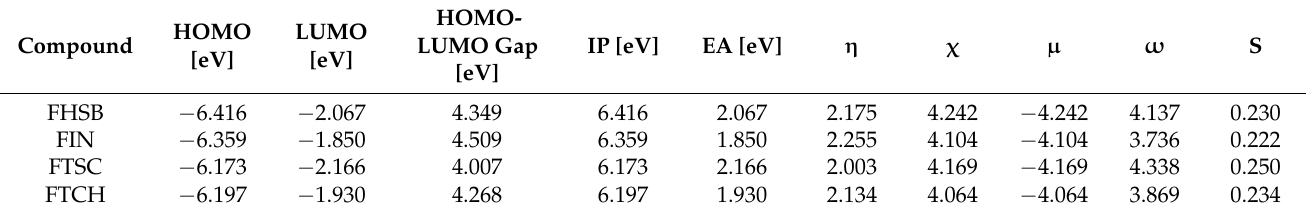
Table 2. Quantum chemical descriptors (hardness ( η ); electronegativity ( χ ); chemical potential ( µ ); electrophilicity index ( ω ); softness (S)) calculated from ionization potential (IP) and electron affinity values (EA), which were estimated by orbital vertical method from the DFT(B3LYP)/6-31+G(d,p) results for the compounds under study.